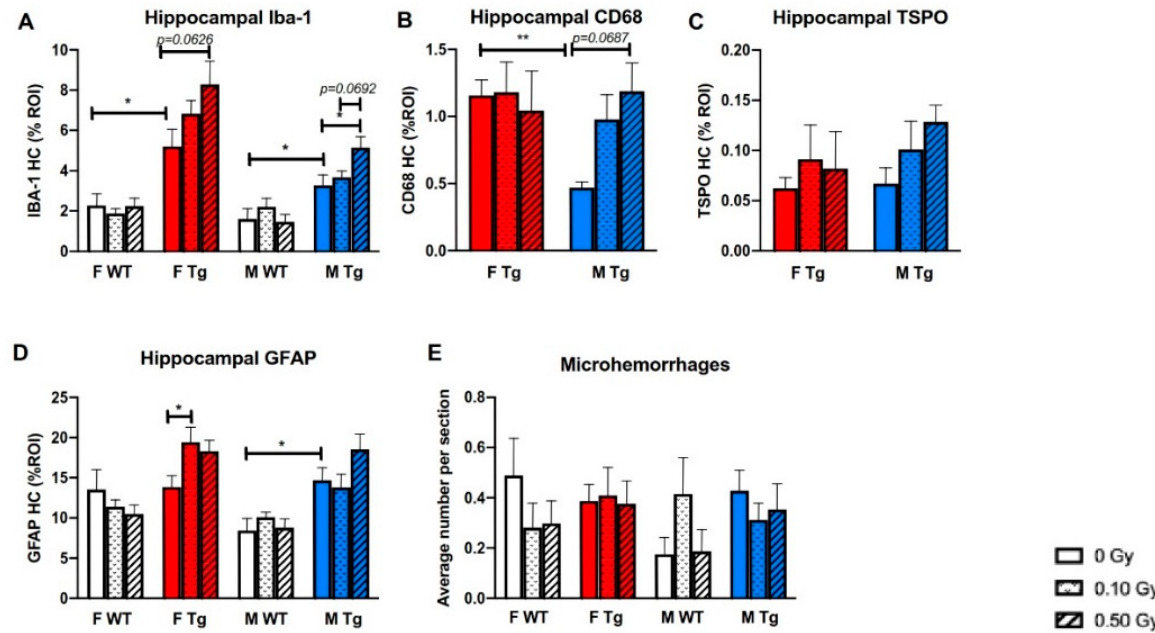
Figure 6. 56 Fe irradiation increased gliosis in female and male APP/PS1 mice but did not affect the number of microhemor- rhages. ( A – D ) Late effects of 56 Fe irradiation on hippocampal gliosis were assessed by immunohistochemical staining and % ROI quantification of microglial markers Iba-1 ( A ), CD68 ( B ) and TSPO ( C ), as well as an astrocyte marker, GFAP ( D ). Microhemorrhages were assessed by Prussian blue staining for hemosiderin deposits ( E ) ( n = 6–9 mice/group). * p < 0.05 and ** p < 0.01. Data were analyzed by 2- or 3-way ANOVAs followed up with 1-way ANOVAs with Tukey comparisons and planned, unpaired, 2-tailed t tests between sham groups as necessary. Non-parametric data were analyzed with the Kruskal–Wallis and/or Mann–Whitney U tests.